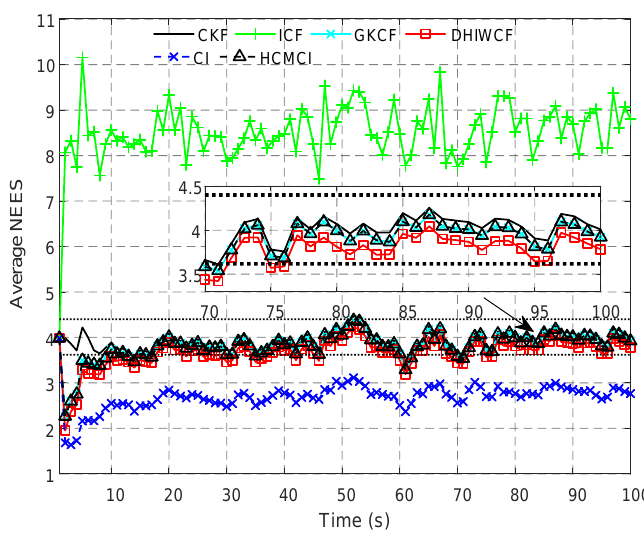
Figure 5. The average normalized estimation error squared (NEES) for the compared algorithms.